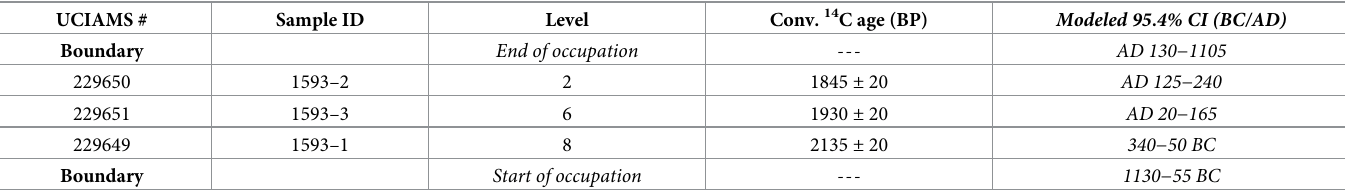
Table 4. Radiocarbon dates for unit NE4B, including modeled sequence, 95% probability ranges, and